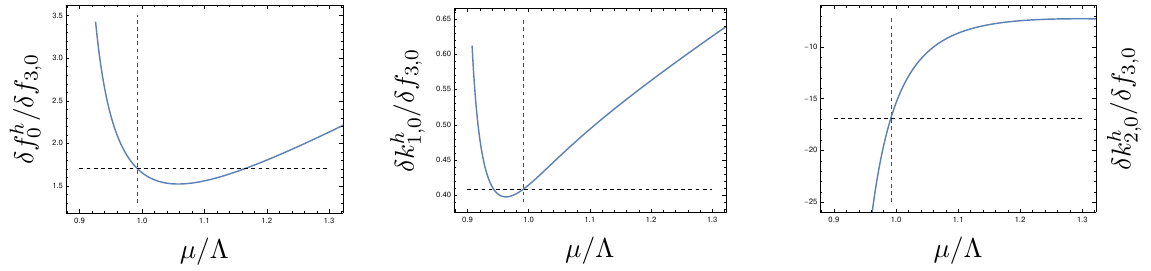
Figure 14 . Susceptibilities of the IR parameters, see (5.35), of the linearized chiral symmetry breaking fluctuations. The red dashed vertical line denotes µ u , see (5.4). The black horizontal dashed lines indicate the values of the susceptibilities at µ = µ unstalble , see (5.36).